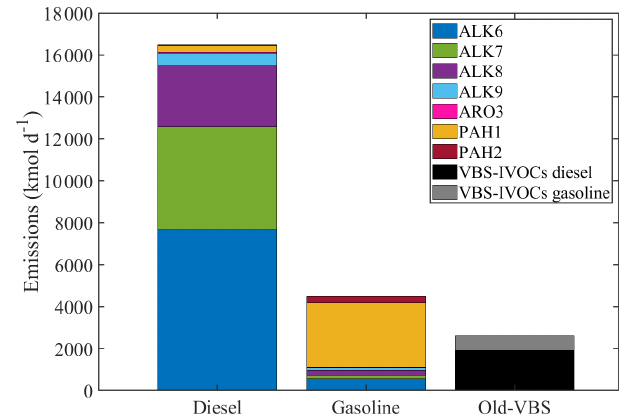
Figure 4. Total emissions from diesel and gasoline vehicles over Europe for May 2008 calculated using the new lumped species ap- proach and using the old VBS approach (signified with grey and